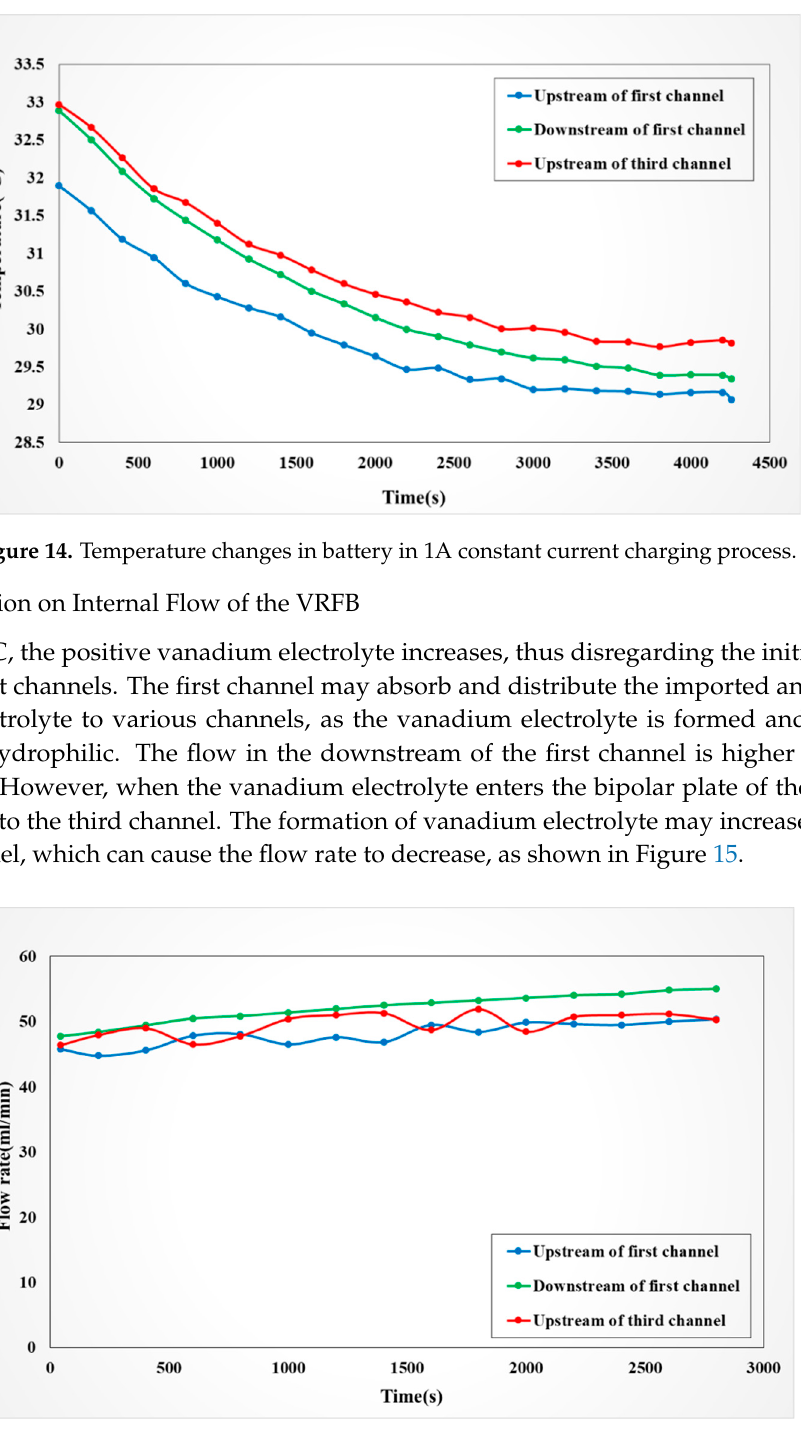
Figure 15. Flow in anode of battery in 1A constant current charging process.